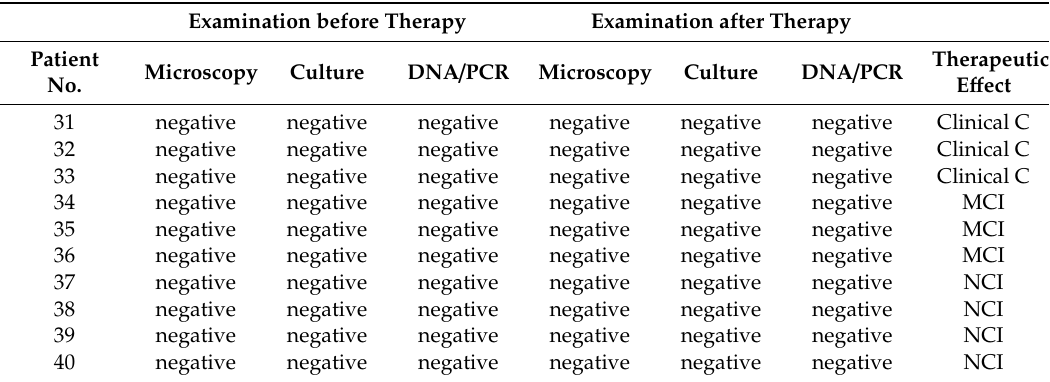
Table 6. Therapeutic e ff ect of NPAR combined with NTP, Protocol 3, in patients with clinical signs of onycholysis but negative mycological examination.